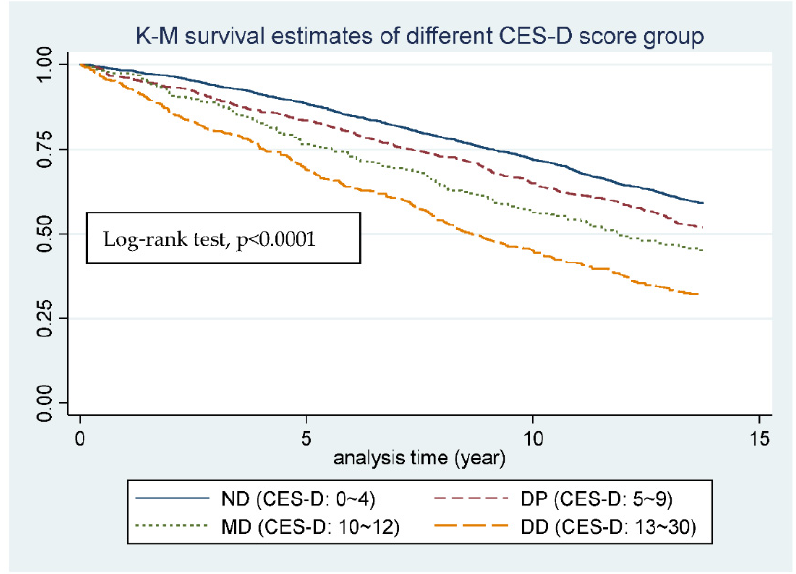
Figure 2. K-M survival estimates of different CES-D score groups.